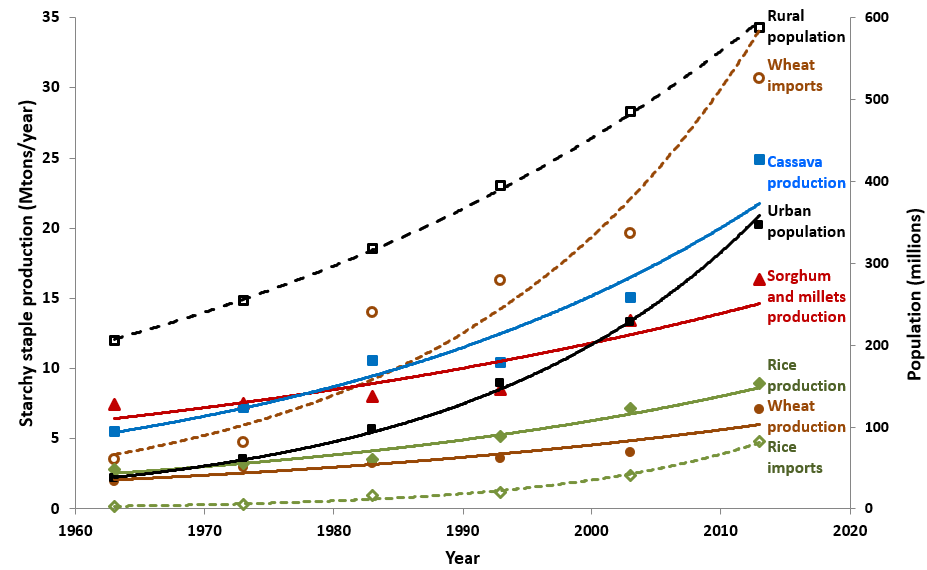
Figure 2. Trends in the production and imports of starchy staples and population size in sub-Sharan Africa from 1963 to 2013 [10].